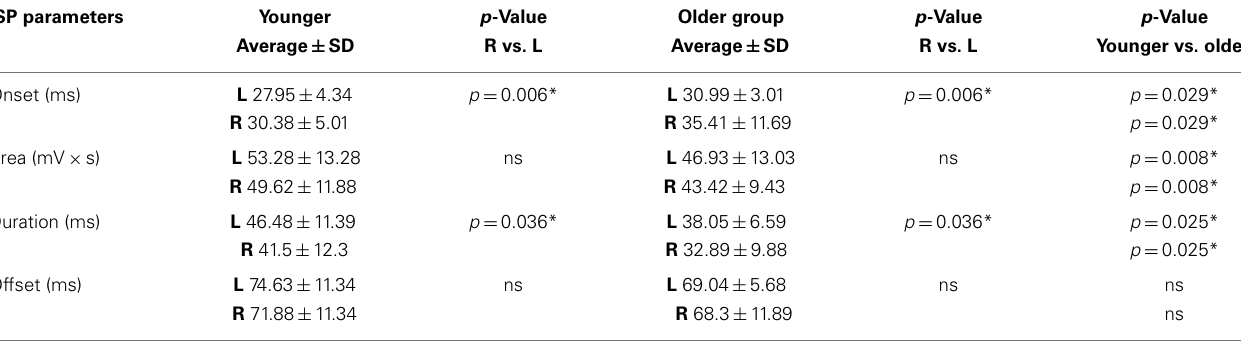
Table 1 | ISP parameters (onset, area, duration, and offset) are shown in both groups of participants (younger and older)